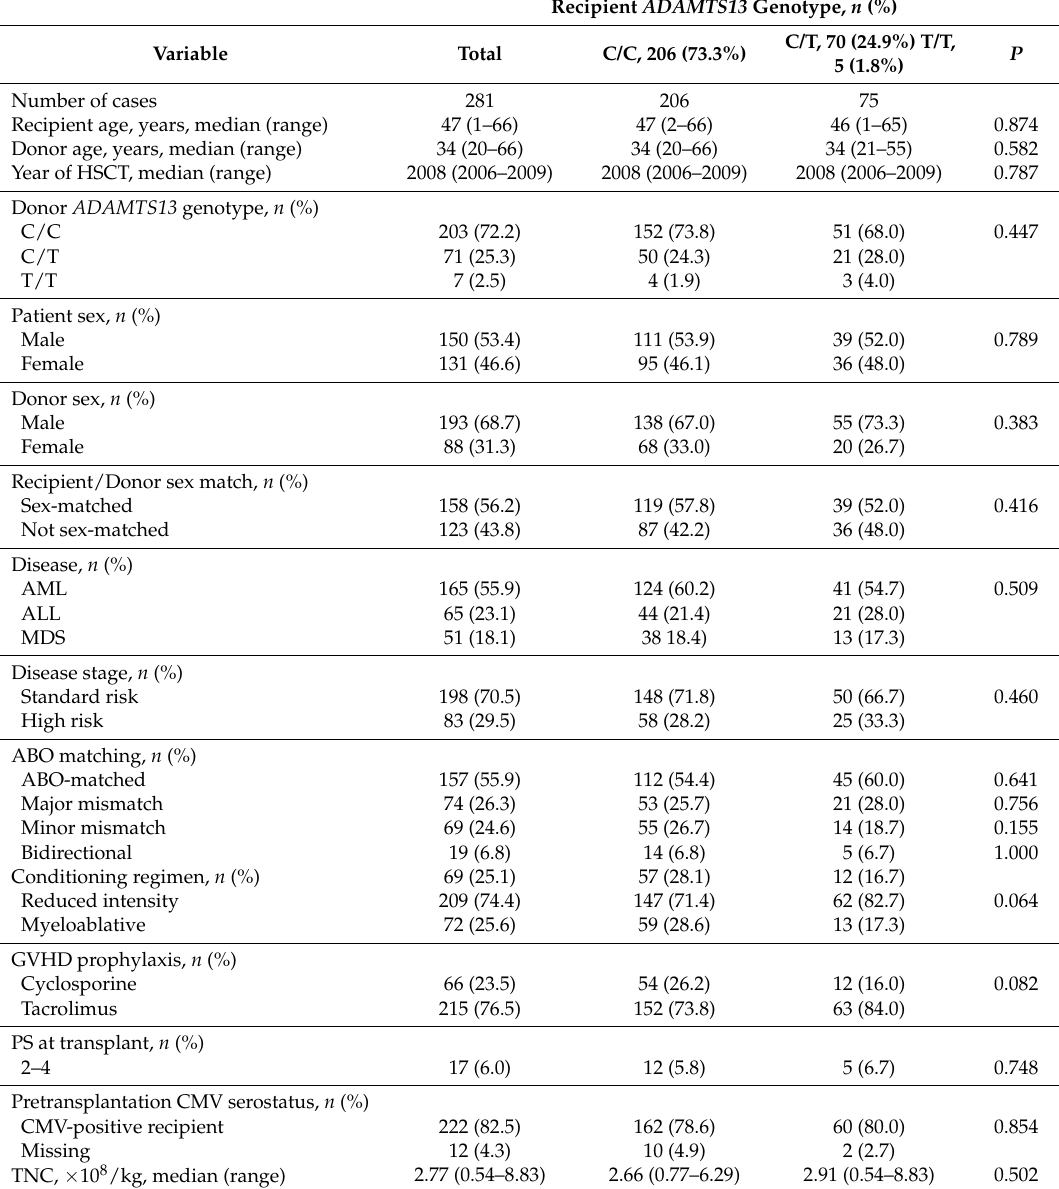
Table 1. Recipient and donor characteristics according to the recipient ADAMTS13